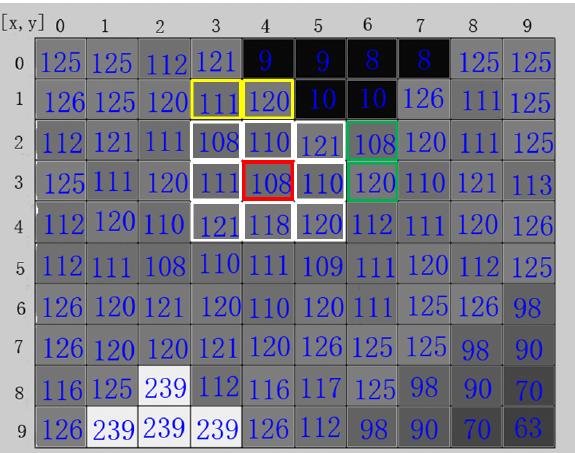
Figure 6: An overview of the smart routing procedure